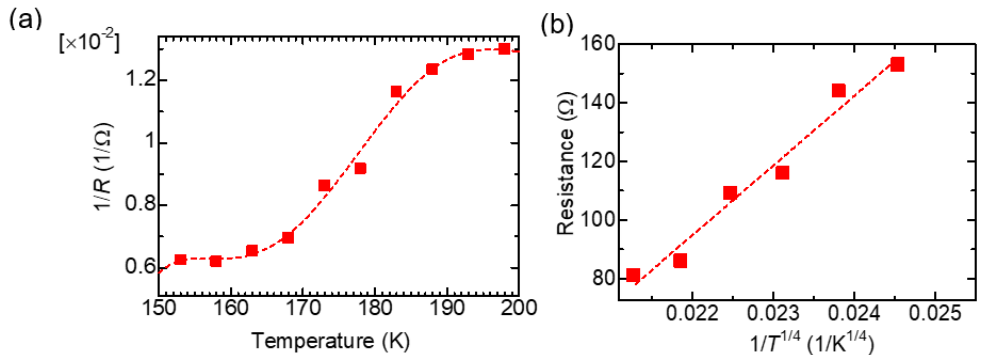
Figure 6. 1/ R ( ∝ σ ) as a function of the temperature of PAZ/Hb ( a ). Resistance vs. 1/ T 1/4 as a Mott plot ( b ) for PAZ/Hb.